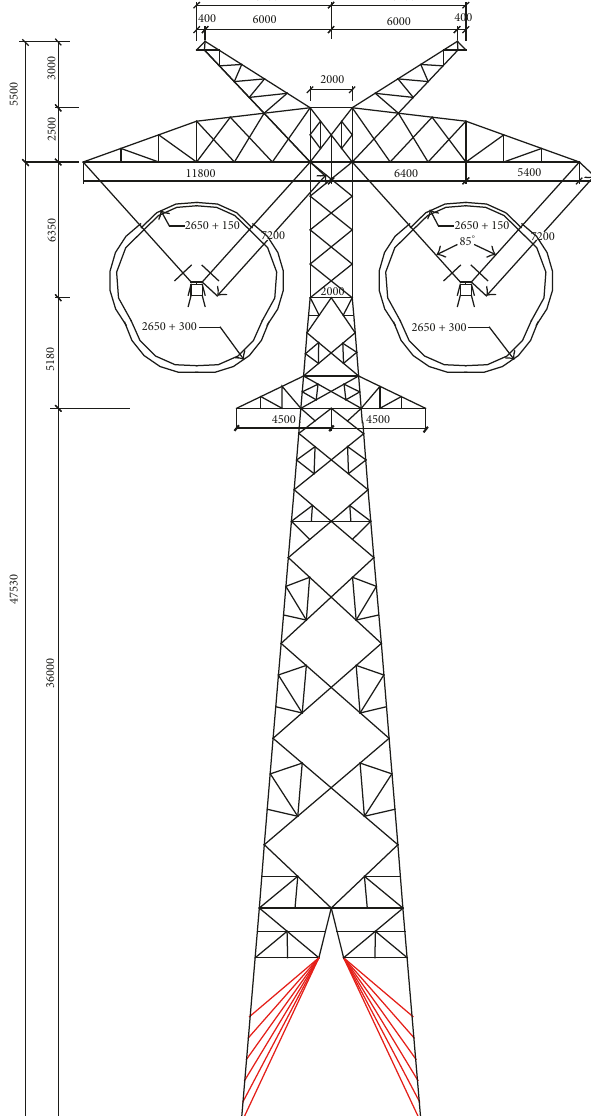
Figure 2: Typical tower diagram of single circuit transmission